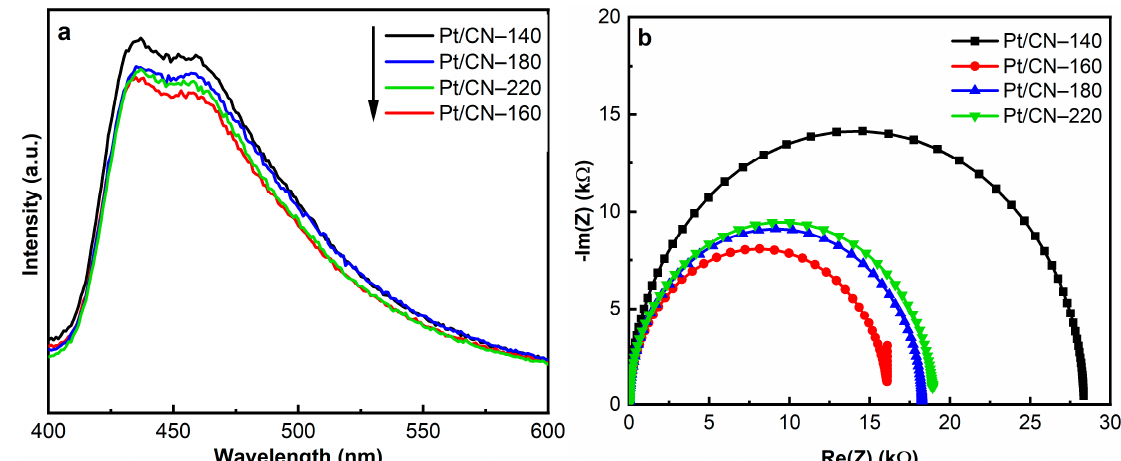
Figure 7. The PL spectra ( a ) and EIS Nyquist plots ( b ) of the Pt/CN photocatalysts.